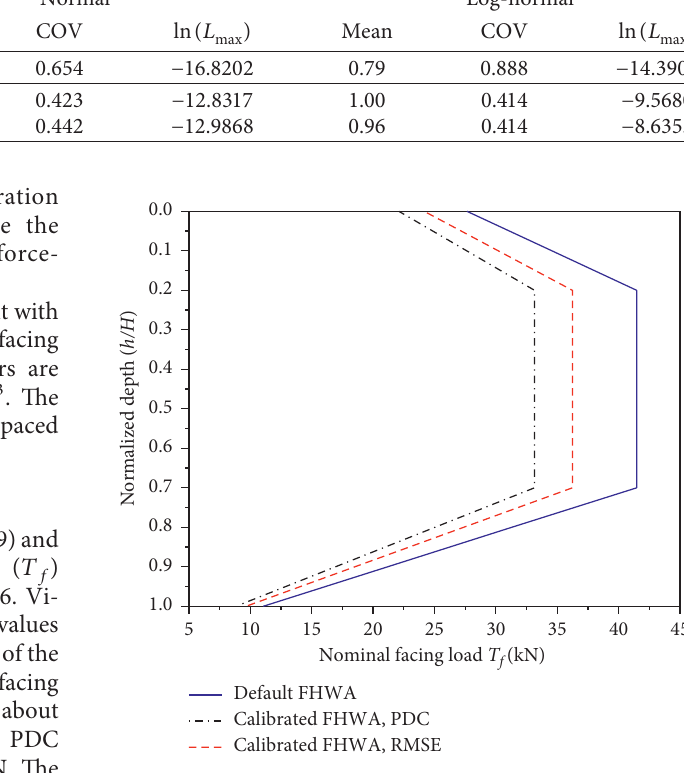
Table 4: Estimated statistics of model bias, λ , or λ ′ using the maximum likelihood method. Model